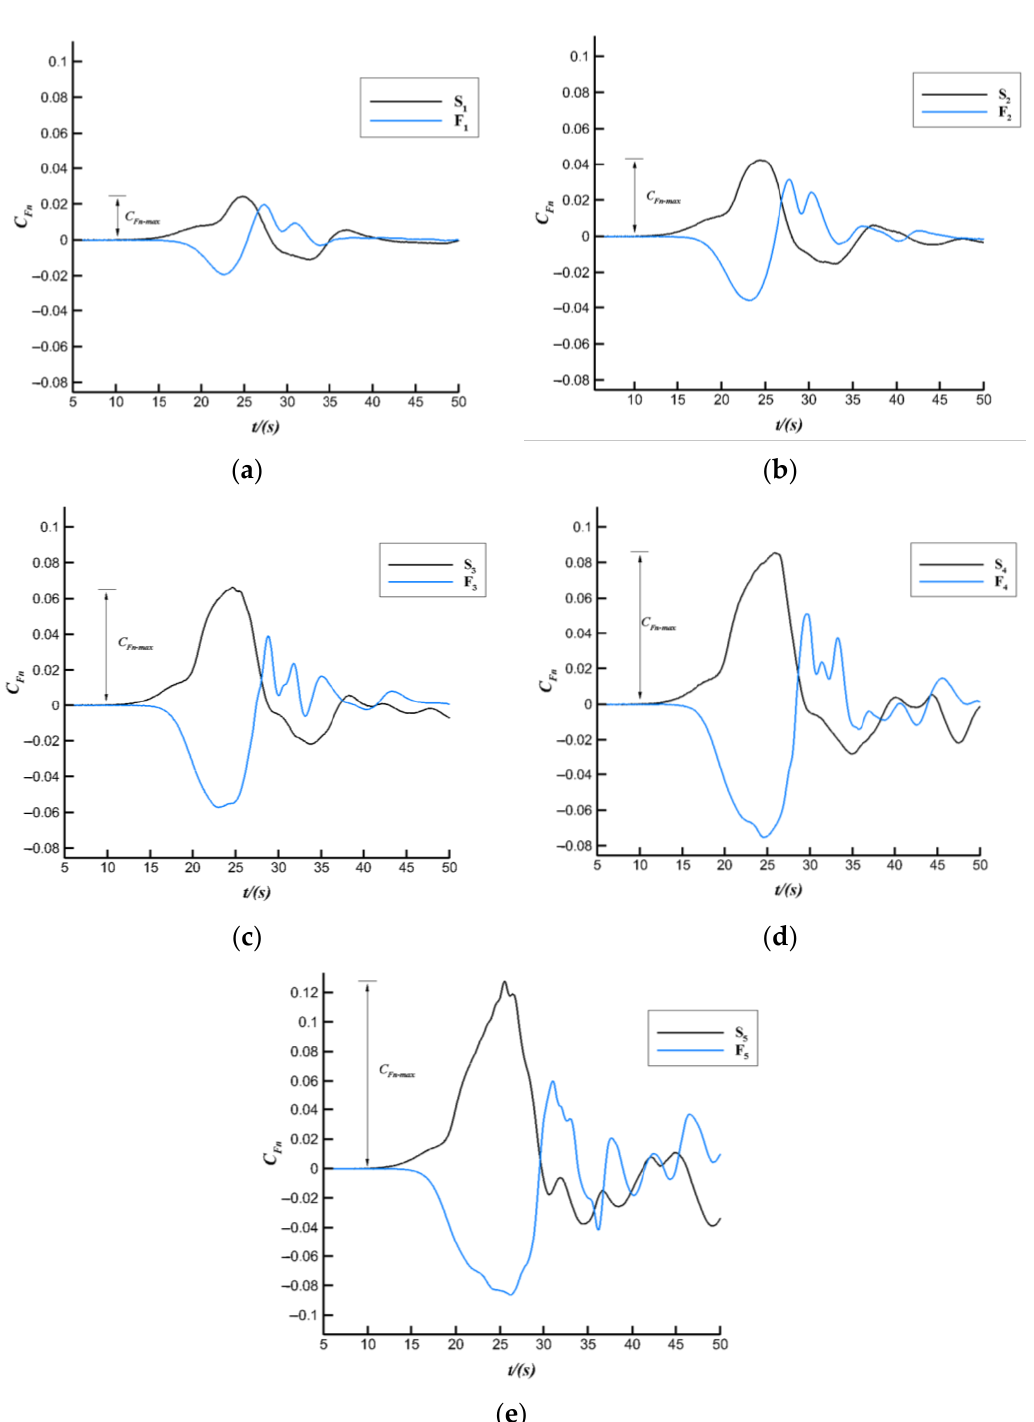
Figure 14. Comparison of C Fn vs. time t between the S case and the F case: ( a ) η 0 /H = 0.0275, ( b ) η 0 /H = 0.0384, ( c ) η 0 /H = 0.0494, ( d ) η 0 /H = 0.0575, ( e ) η 0 /H = 0.0674.